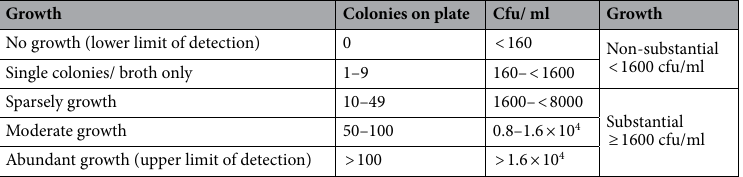
Quantification by real‑time PCR.